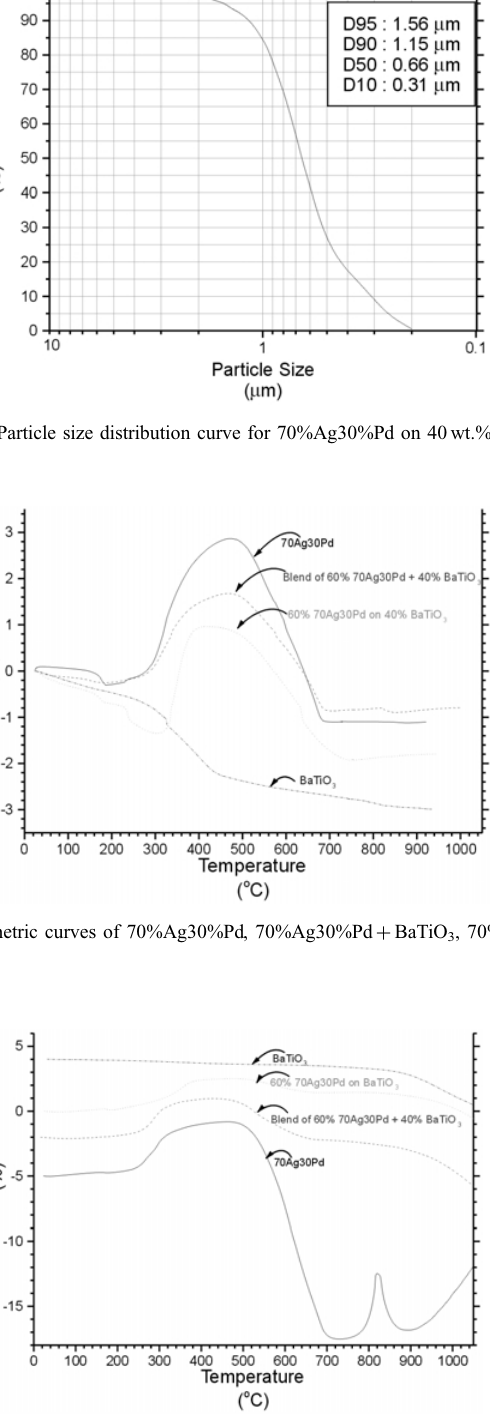
FIGURE 4 Thermal-mechanical traces of 70%Ag30%Pd, 70%Ag30%Pd þ BaTiO 3 , 70%Ag30%Pd coated onto